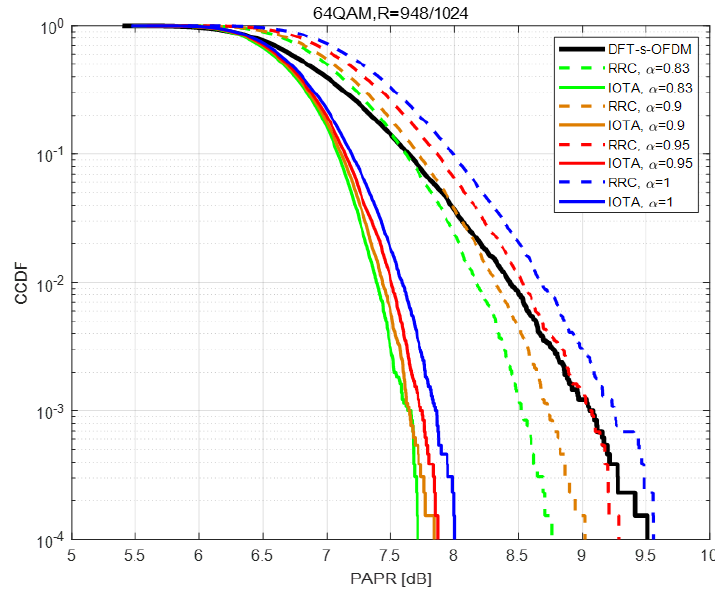
Figure 6. Performance of PAPR based on 64QAM with R =